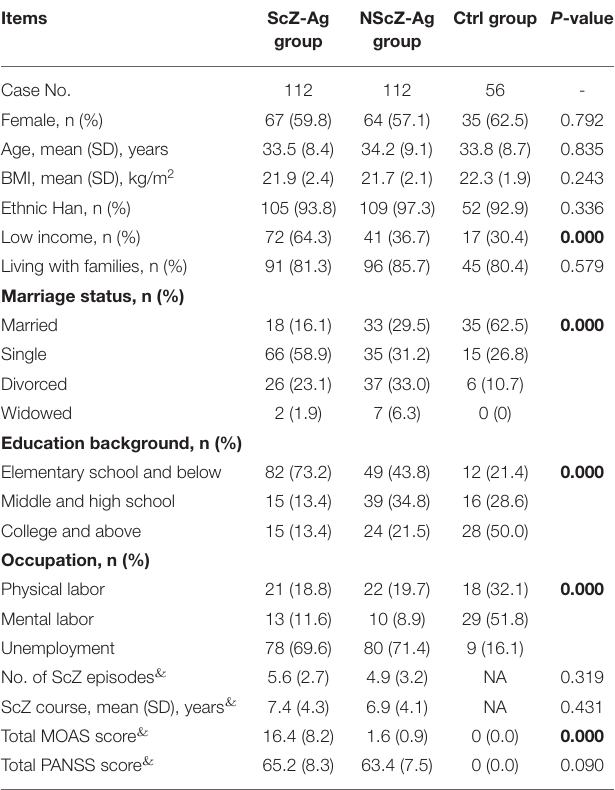
TABLE 1 | Clinic characteristics of all inpatients at baseline. Items ScZ-Ag NScZ-Ag Ctrl group P -value group group using Bonferroni’s multiple comparison test found that none of inflammatory markers differed significantly between NScZ-Ag and Ctrl groups (all P > 0.05), while serum levels of CRP, IL-6, IL- 1 β , and TNF- α dramatically increased approximately two to five times on average in ScZ-Ag group in comparison with NScZ-Ag group (all P < 0.001). On partial correlation analysis